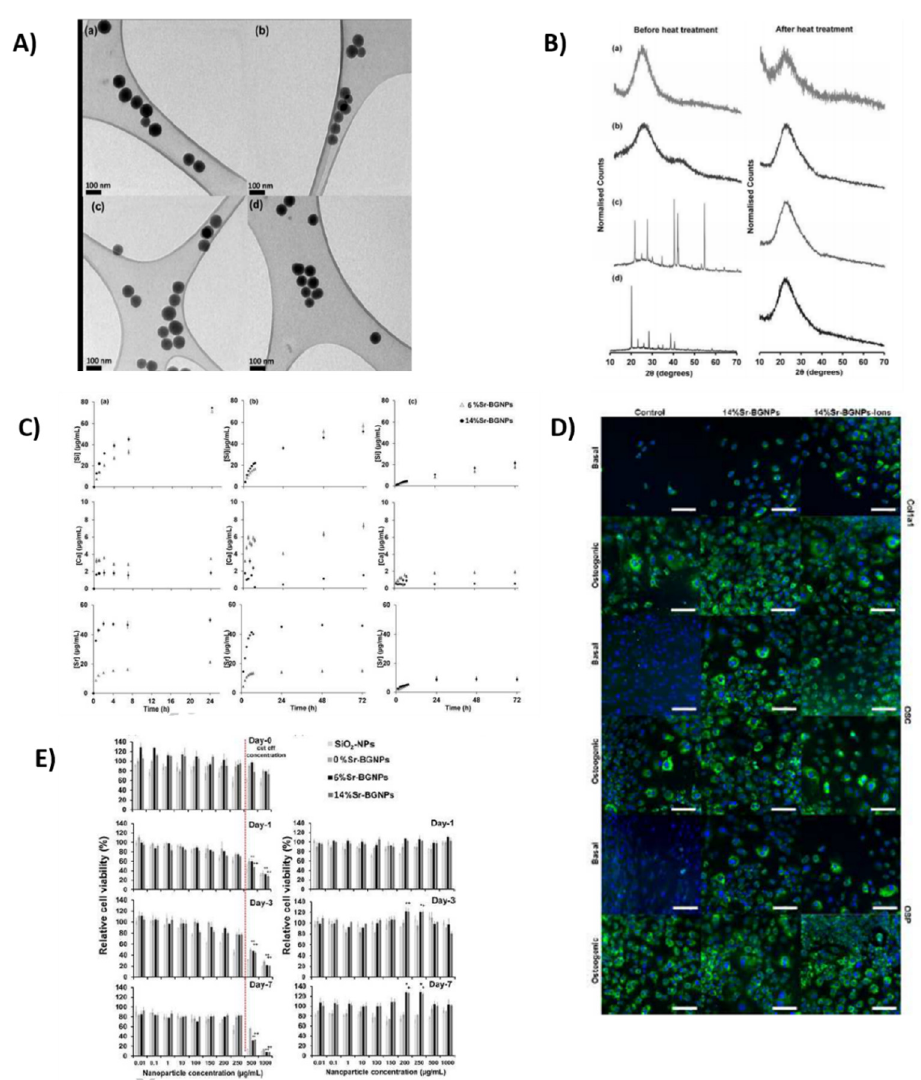
Figure 10. ( A ) TEM images of Sr-BGNPs; ( a ) silica NPs reference sample, ( b ) 0% Sr-BGNPs, ( c )